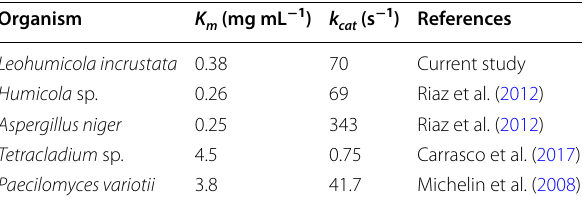
Table 4 Comparison of the kinetic